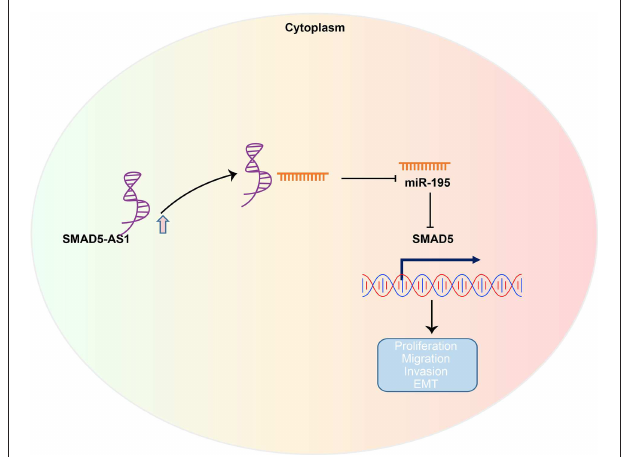
FIGURE 8 | The regulatory network and function of SMAD5-AS1 in NPC. LncRNA SMAD5-AS1 upregulates SMAD5 expression by competitively binding to miR-195, thereby promoting EMT of